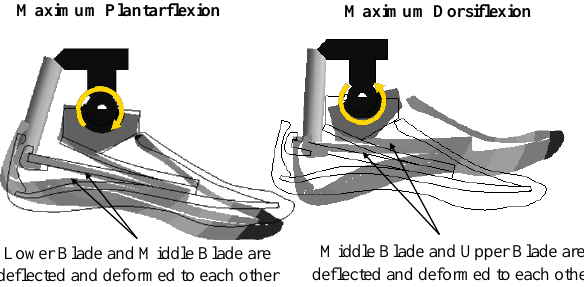
Figure 2. Deflection of the blades in respect to each other when the foot prosthesis is loaded at the heel and at the